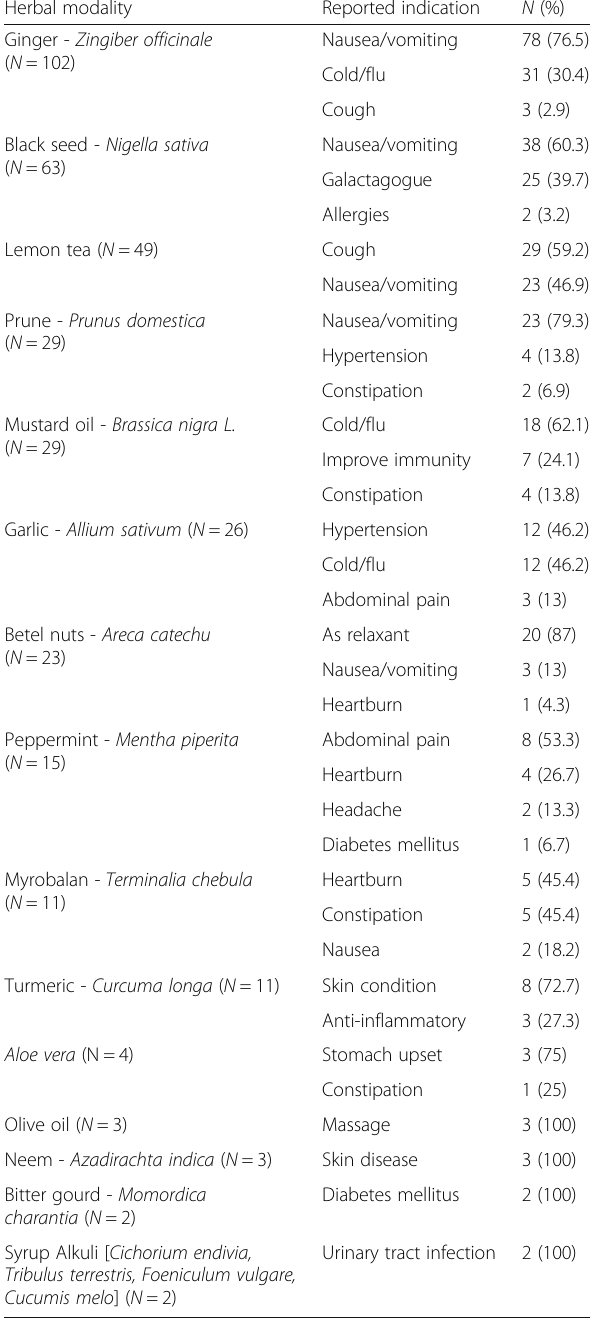
Table 4 Reported indications of herbal medicine according to each modality (multiple